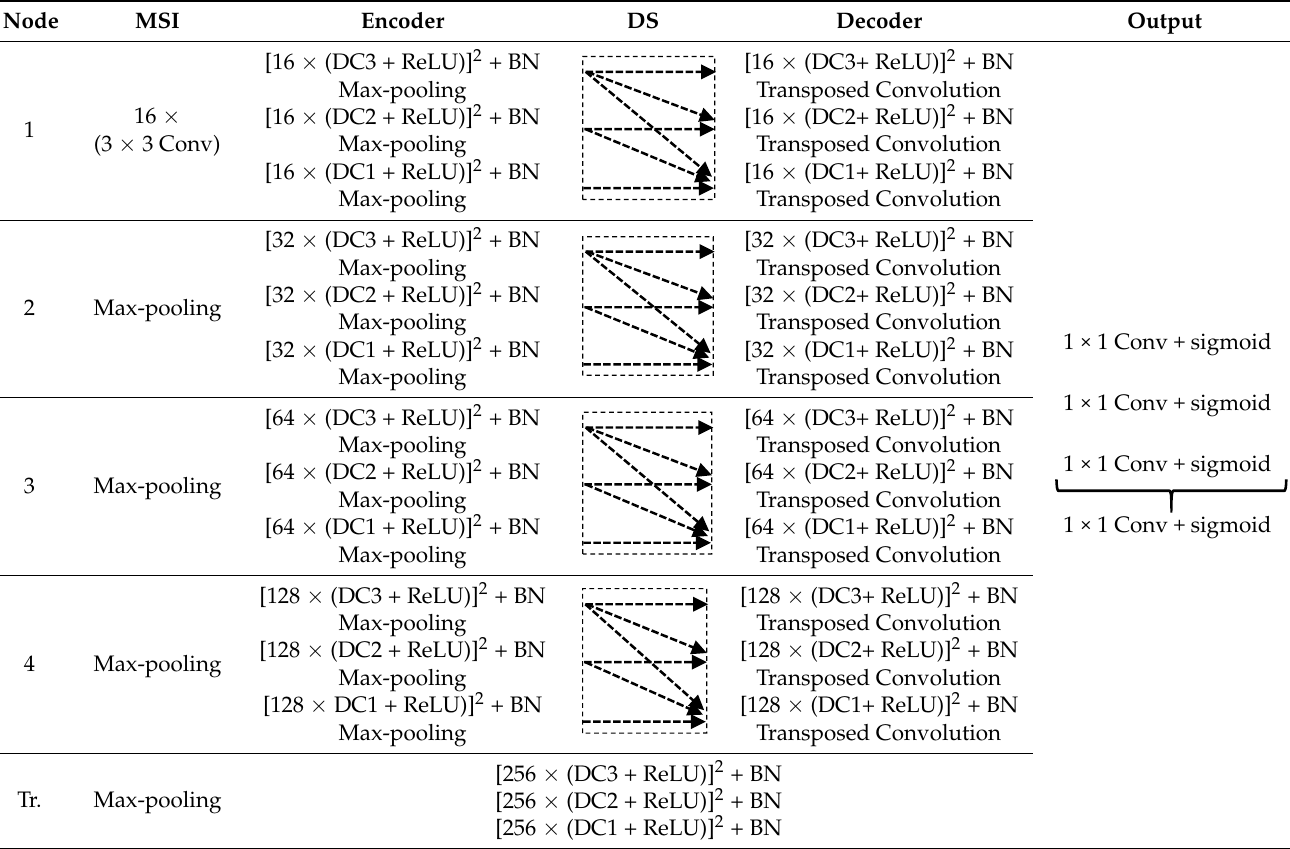
Table 1. The architecture of TMD-Unet.